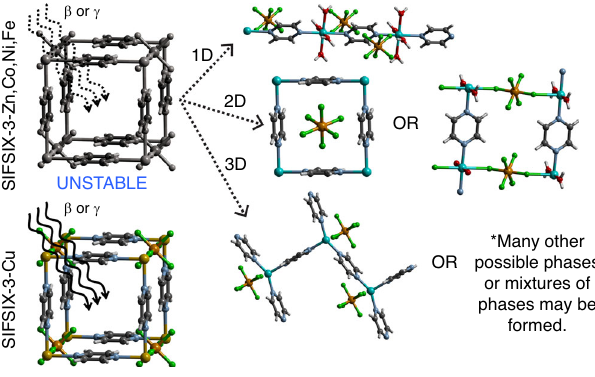
Fig. 2 Illustration of impact of irradiation on SIFSIX-3-M materials. The SIFSIX-3-M (M = Zn, Co, Ni, Fe) structures decompose to 1D, 2D or many other possible phases up on radiation exposure. The SIFSIX-3-Cu is stable and maintains its original crystal structure up to 50 kGy dose in beta or gamma radiation. Atom colors: C = gray, H = white, N = light blue, F = green, Si = light brown, Cu = orange, M (Ni, Co, Fe, Zn) = cyan, O =